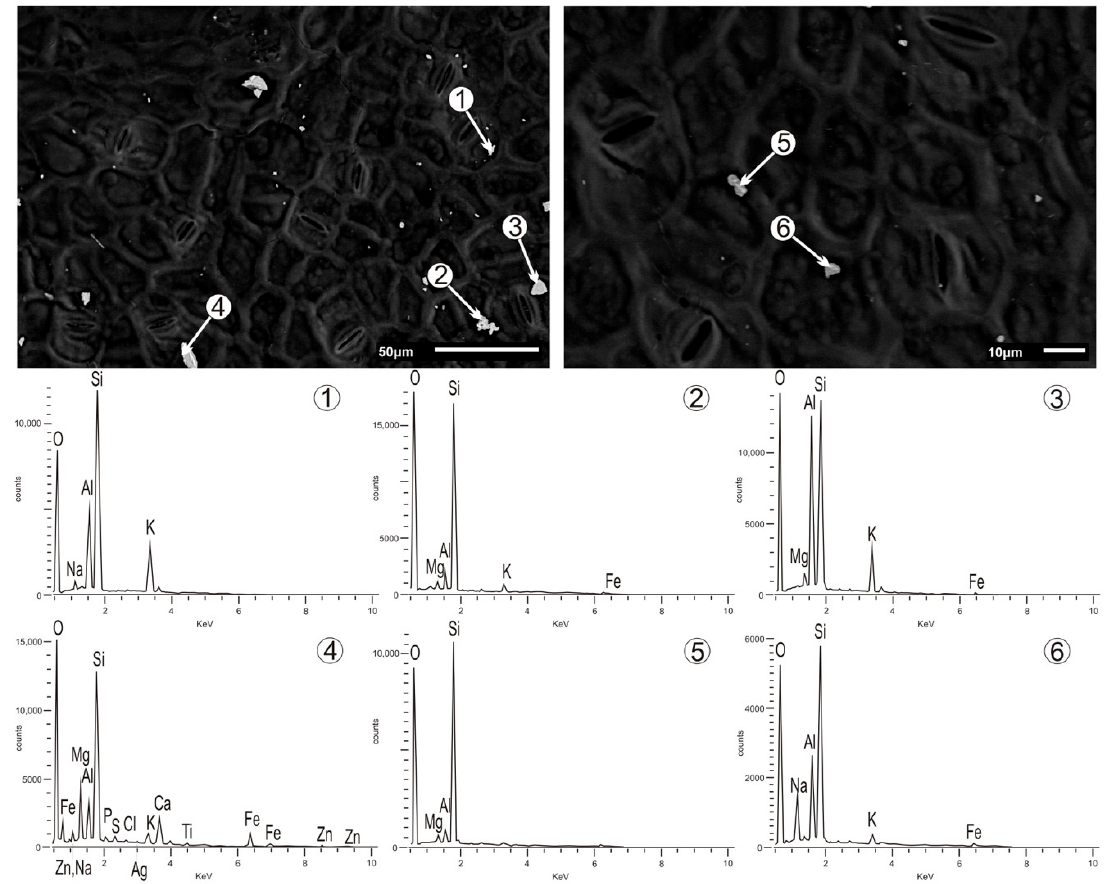
Figure 4. BSE image of P . nigra leaves taken from site 14 and representative EDX spectra. Spectrum 1 —alkali feldspar; spectrum 2 —silica (quartz); spectrum 3 —illite; spectrum 4 —silicate slag/ash with Zn; spectrum 5 —silica (quartz); spectrum 6 —sodium feldspar.